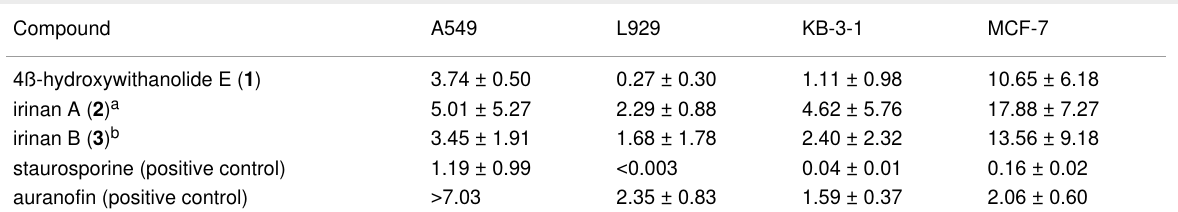
Table 2: Antiproliferative activities in different cell lines. Data indicate EC 50 values ± SD in µM. A549 = human lung carcinoma; L929 = mouse fibro- blast; KB-3-1 = human cervix carcinoma; MCF-7 = human breast cancer cell line.